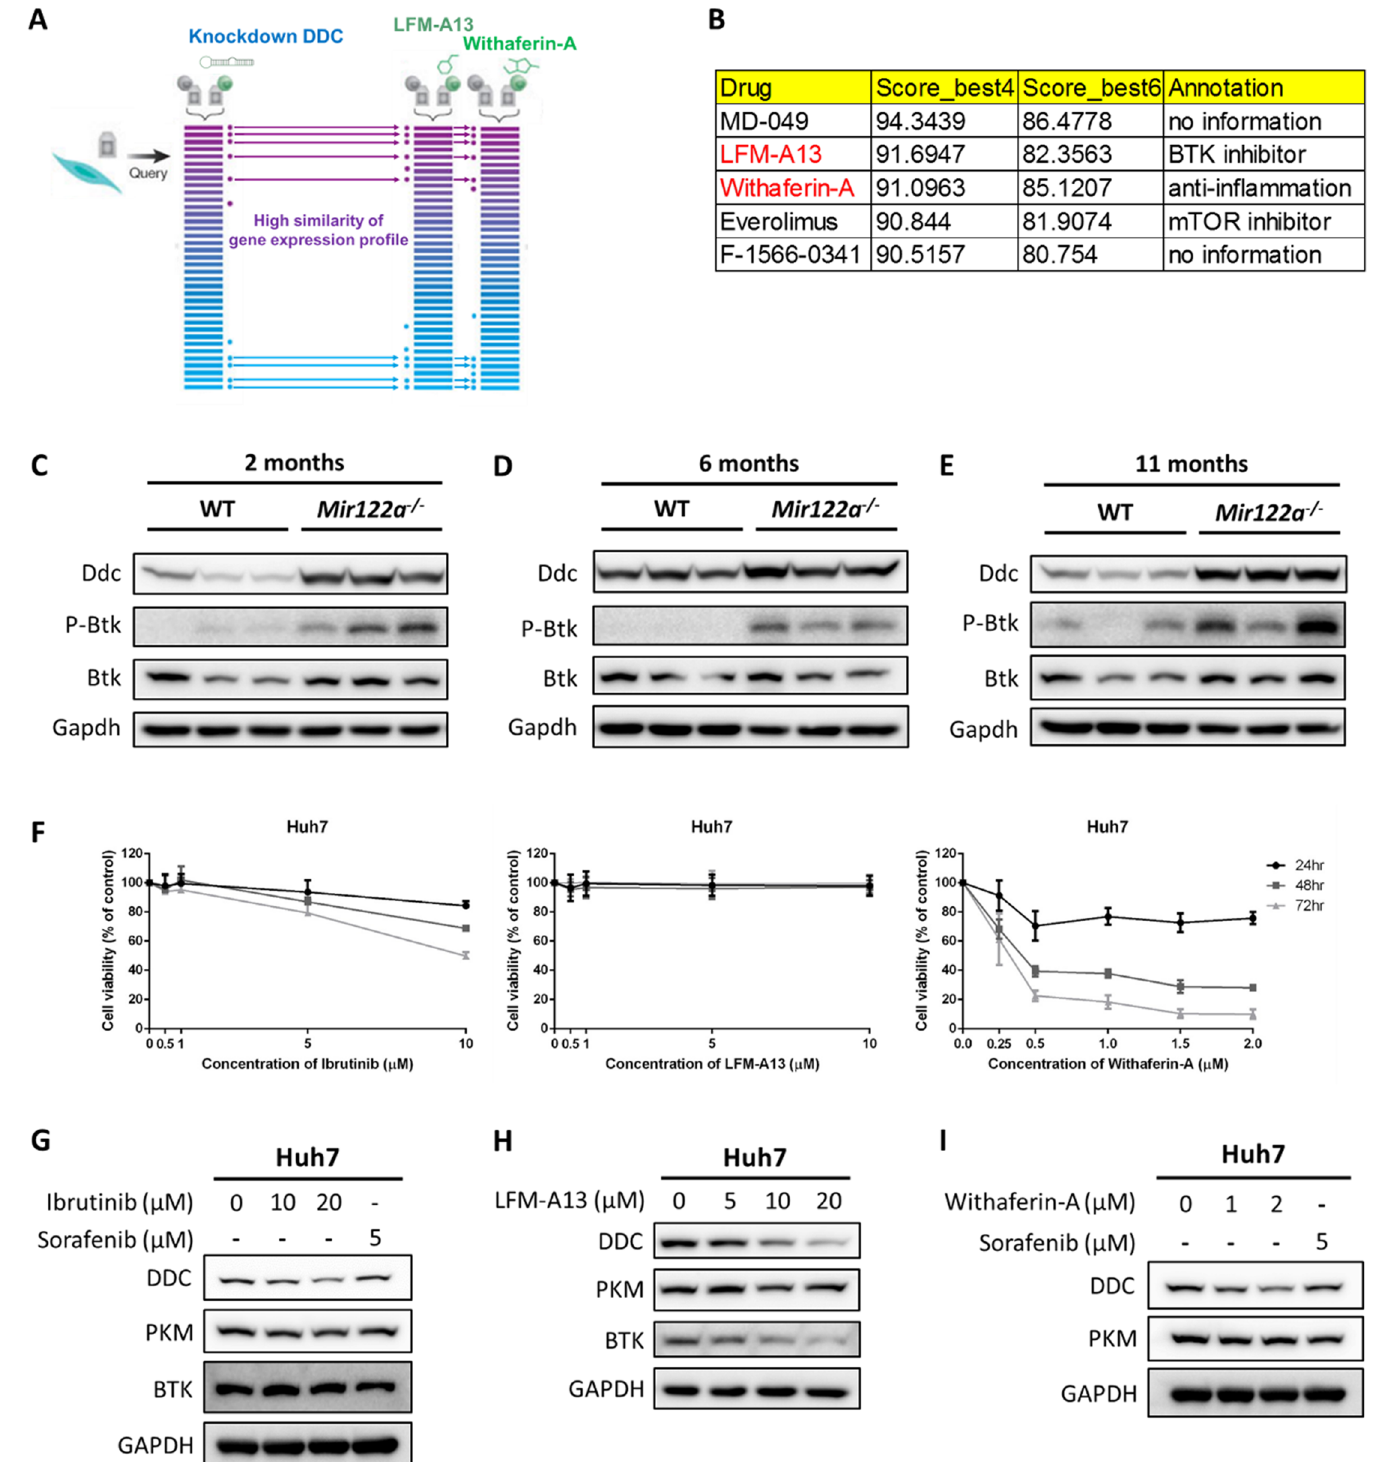
Fig 4. Downregulation of DDC expression by treatment with ibrutinib, LFM-A13, and withaferin-A. (A) Schematic illustration of similar gene expression signaturesbetween DDC shRNA and chemicalcompounds.(B) We queriedthe DDC shRNA gene signaturevia LINCS databaseand found BTK inhibitor (LFM-A13), withaferin A, and several compoundsshared similar geneexpressionprofiles with DDC shRNA gene signature. Score_best4and score_best6 are the mean connectivity scores across the four and six cell lines, respectively,in which the perturbagen connectedmost strongly to the query